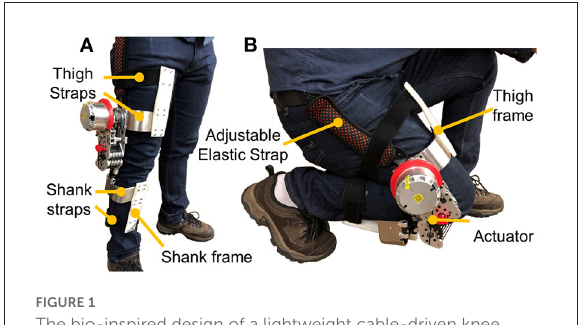
FIGURE1 The bio-inspired design of a lightweight cable-driven knee exoskeleton aims to reduce negative design effects in terms of joint misalignment mitigation, lightweight, and high compliance. (A) Side view in a standing position. (B) Crouched down posture that demonstrates the wide range of motion of the device, being not restrictive of the wearer’s free movements.